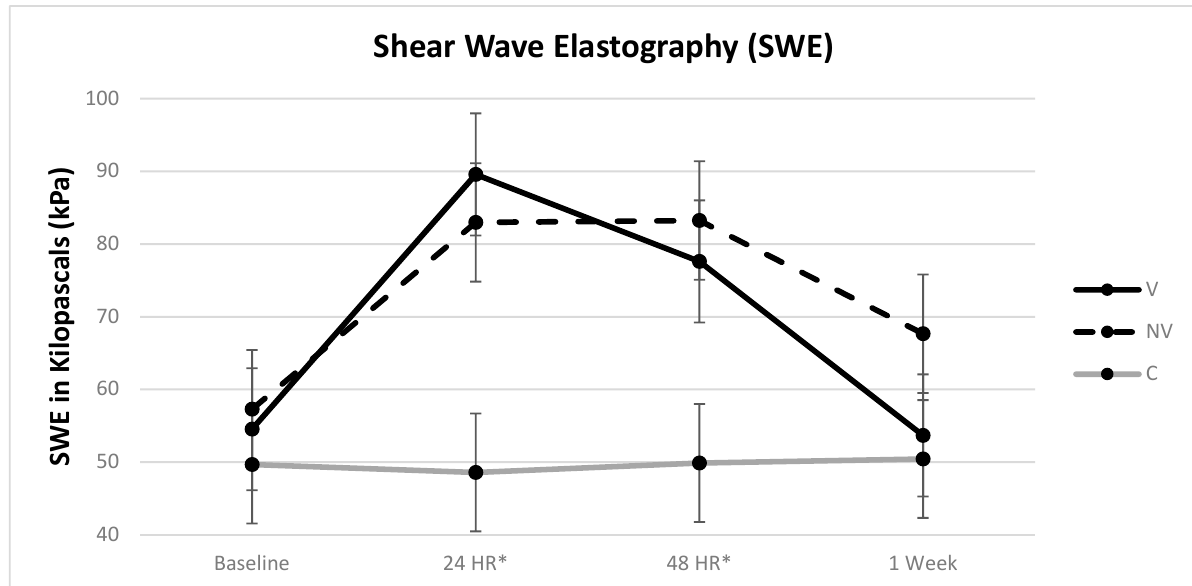
Figure 6. Shear-wave elastography values by group over time. * = control different from treatment groups (bars represent the 95% confidence interval values).